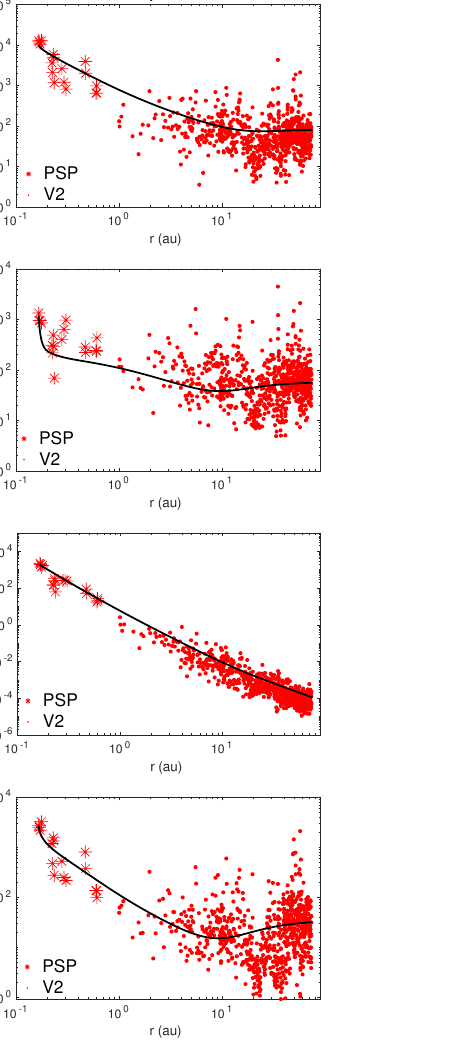
Figure 2. From top to bottom in the upwind ( left column) and downwind (180 ◦ — right column) directions, the theoretical and observed energy in forward propagating modes, energy in backward propagating modes, fluctuating magnetic energy, and fluctuating kinetic energy are compared as a function of heliocentric distance. The solid curve denotes the theoretical result. The red “*” symbols and “.” symbols represent PSP and Voyager 2 measurements,